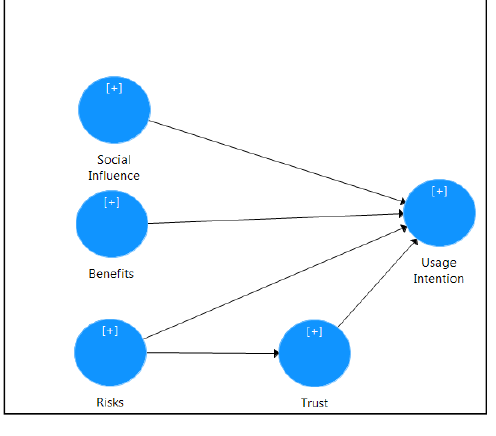
Figure 1. Research model.